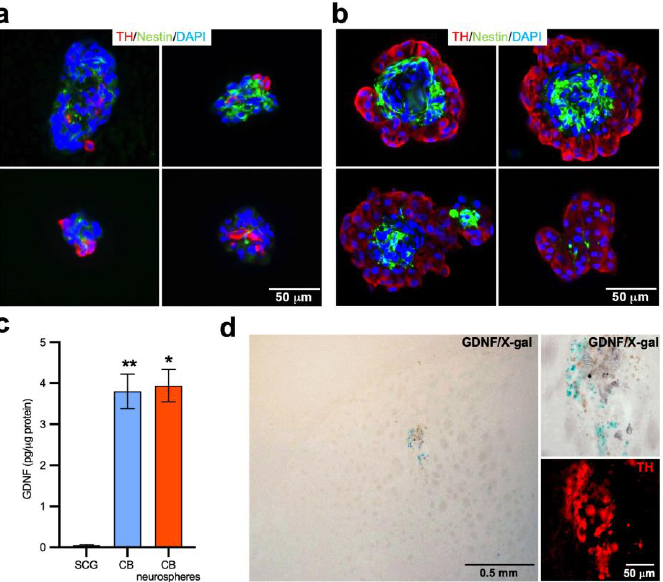
Figure 1. Characteristics of CB stem-cell-derived neurospheres . ( a , b ) High-magnification images of four representative examples of mouse ( a ) and rat ( b ) CB stem-cell-derived neurospheres after TH (red), nestin (green) and nuclear DAPI (blue) immunofluorescence. Note the presence of blebs with abundant TH + glomus cells in the rat CB neurospheres. ( c ) GDNF content, expressed in pg/μg of total protein, of rat superior cervical ganglion ( n = 7; SCG), native CB tissue ( n = 6) and CB neuro- spheres ( n = 3). ( d ) GDNF expression in intrastriatally grafted CB neurospheres from GDNF/X-gal heterozygous mice. The high magnification images in the right panels show the coincidence be- tween the GDNF/X-gal (blue) and TH (red) fluorescence signals, clearly demonstrating the GDNF expression on grafted TH + glomus cells. In c, the Kruskal–Wallis test and post hoc Dunn’s test were performed. * p < 0.05; ** p < 0.01, in respect to SCG.